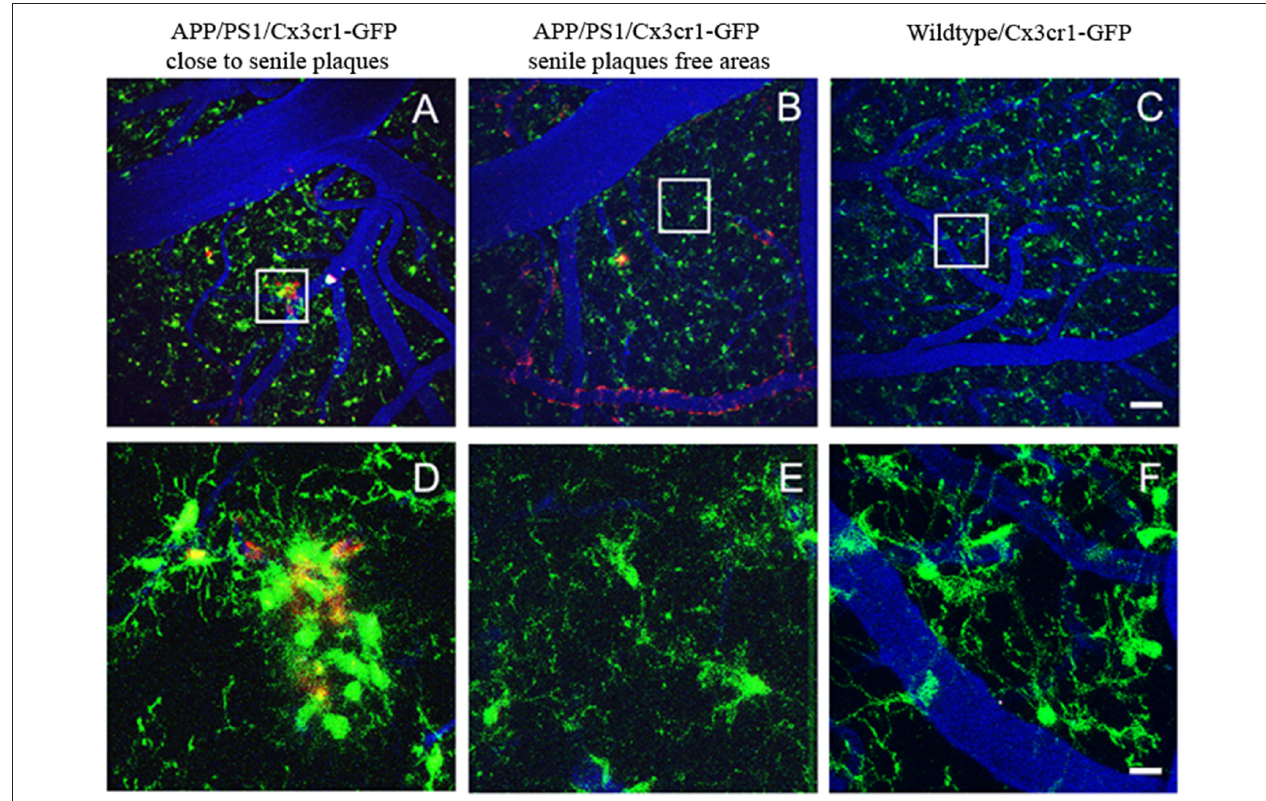
FIGURE 3 | Real time in vivo multiphoton imaging of microglia in the cerebral cortex from APP/PS1 × CX3CR1-GFP mice. Representative images of microglia clusters around senile plaques (A,D) , in areas free from senile plaques (B,E) , and in a wildtype mouse (C,F) . Vessels (blue) are filled with Texas Red dextran 70 KD, senile plaques are labeled with methoxy-XO4 (red), and microglia express GFP (green). The scale bar is 50 µ m and for the insets 10 µ